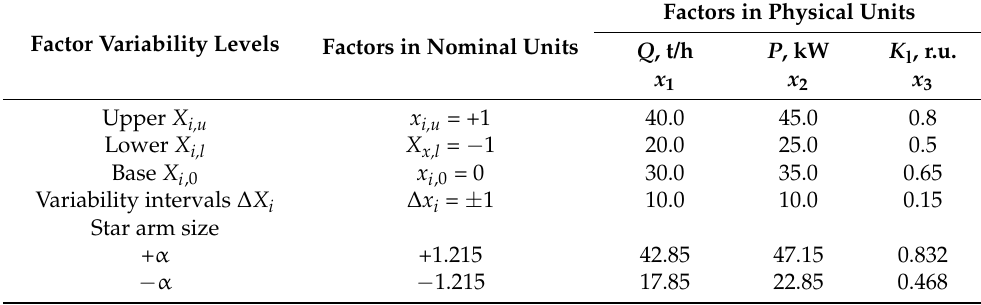
Table 1. Factor levels and variability intervals for